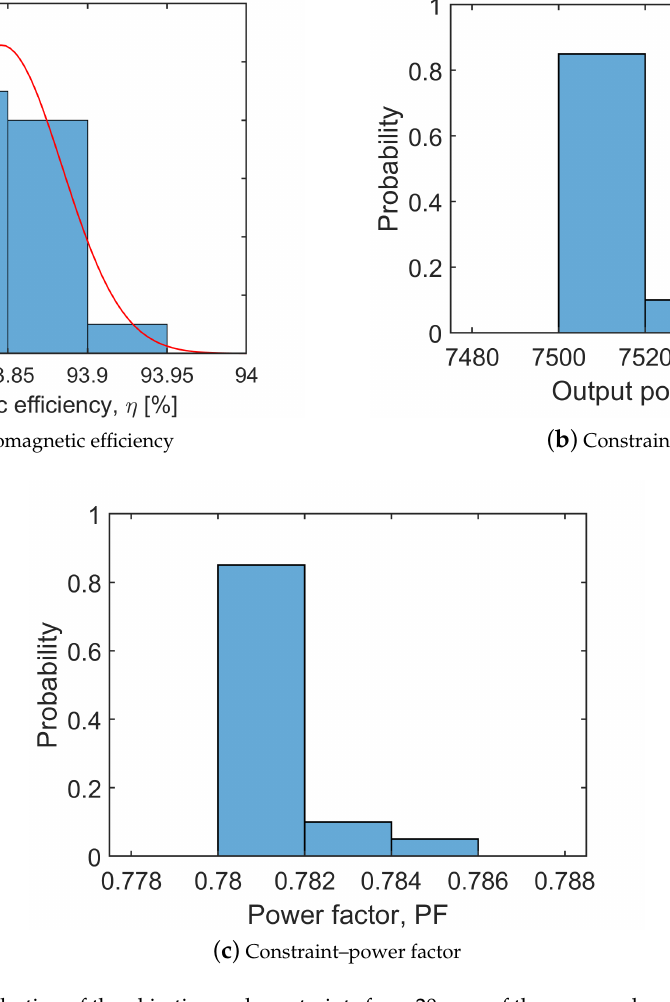
Figure 11. Probability distribution of the objective and constraints from 20 runs of the proposed surrogate optimization